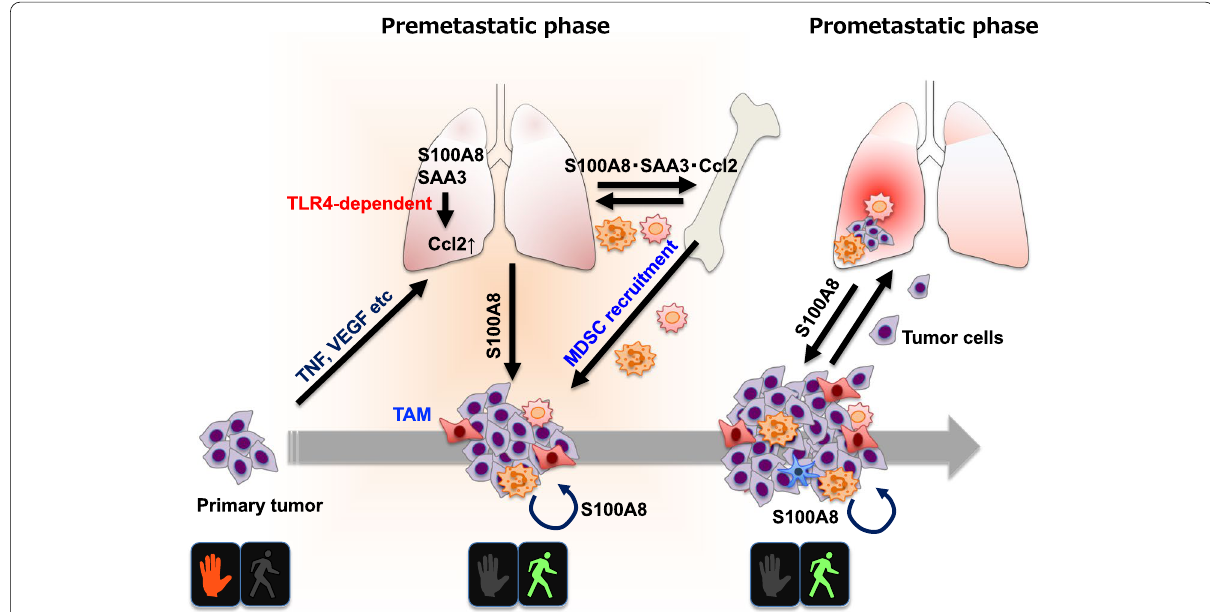
Fig. 2 The recruitment of myeloid-derived cells is a crucial step in metastasis. In the early phase of the primary tumor, it is not ready for myeloid-derived cells (inflammatory monocytes, MDSCs) to recruit primary tumor sites and distant organs (in this case, the lungs; do not walk). Once tumors develop to a certain size and acquire invasiveness, the primary tumor microenvironment secretes cytokines/chemokines (i.e., VEGF, TNFα, and TGF-β) to produce S100A8 in the lungs. These chemokines, such as Ccl2, S100A8/S100A9, can send a signal to myeloid-derived cells in bone marrow as